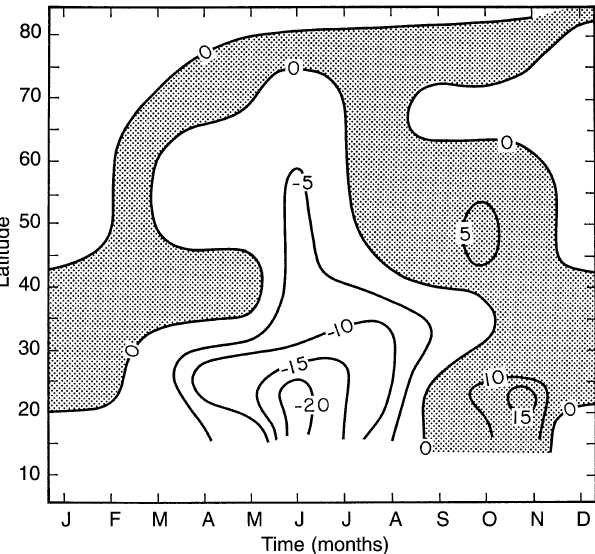
Fig. 5. Zonally averaged precipitation anomalies due to orbital variations for 4 kyears AP (isotherms in 0.1 °